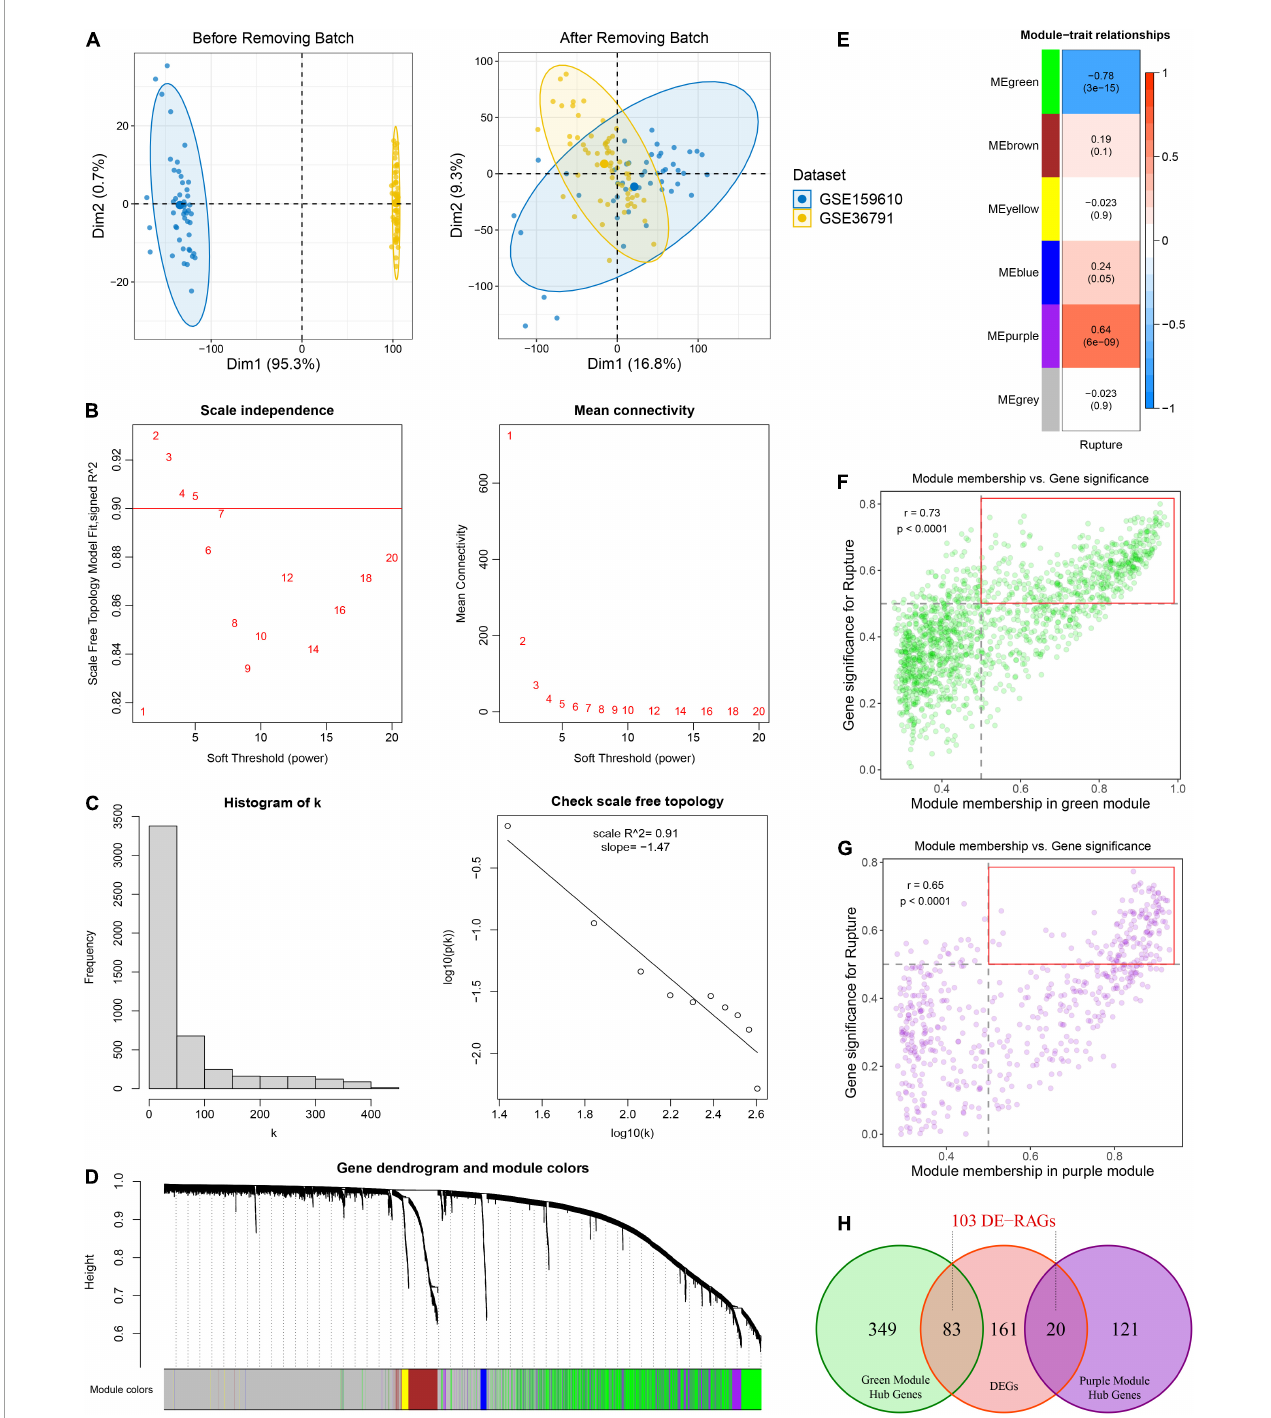
FIGURE2 Identification of rupture-associated genes (RAGs) by WGCNA algorithm. (A) Principal component analysis before and after removing batch effects from non-biological technical biases. (B) Scale-free network analysis under different soft-thresholding powers. When the soft power of β ≥ 3, the scale-free R 2 is greater than 0.9 and mean connectivity tends to be stable. (C) Histogram of connectivity distribution and checking the scale free topology when β = 3. (D) Gene hierarchical clustering under optimal soft-thresholding power. Genes with similar expression patterns were assigned to co-expression modules represented by the same color. (E) Heatmap of the correlation between module eigengenes and rupture status. Red and blue represent positive and negative correlations, respectively. (F,G) Correlation between GS and MM in the green (F) and purple (G) modules. Dots within the red rectangle were defined as hub RAGs, with both high GS and MM. (H) Venn diagram of intersection between hub RAGs and differentially expressed genes (DEGs).